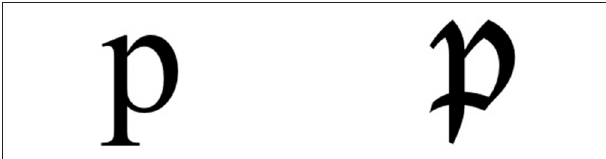
FIGURE 1 | On the left side, a p written in the font Times New Roman. On the right side, a p written in the font Lucida Blackletter.